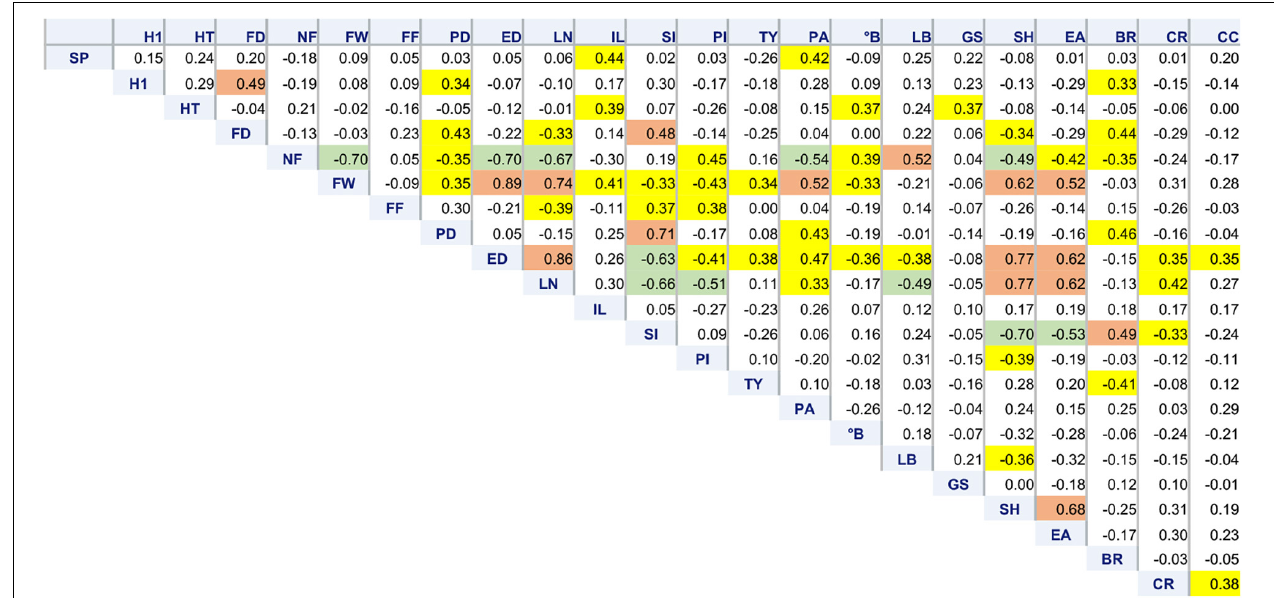
FIGURE 4 | Correlation matrix of 22 morphological traits. Pearson’s coefficients calculated among 64 tomato accessions for variables showing at least one significant correlation, including stigma position (SP), plant height at the first node (H1), total plant height (HT), flowering date (FD), number of fruits (NF), fruit weight (FW), fruit firmness (FF), polar (PD) and equatorial (ED) diameter, locule number (LN), internode length (IL), fruit shape index (PI), pericarp index (PI), total yield (TY), puffiness appearance (PA), total soluble solids ( ◦ B), leaf border (LB), green shoulder (GS), fruit shoulder shape (SH), easiness to detach (EA), blossom end rot (BR), radial (RC), and concentric (CC) cracking. Coefficients significant for p ≤ 0.01 are highlighted in yellow. Significance for p ≤ 0.0001 is highlighted in green or brown if negative or positive, respectively.